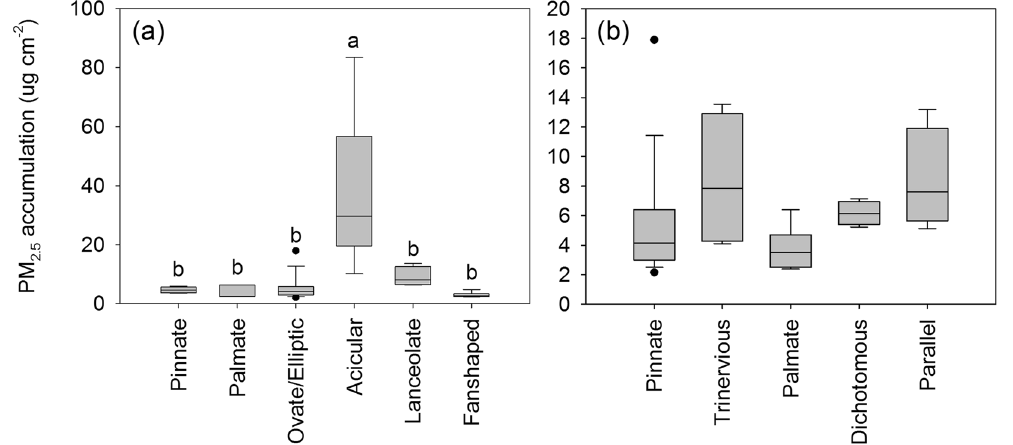
Figure 2. Differences in foliar PM 2.5 accumulation between different leaf shapes ( a ) and venation patterns ( b ) pooled from all species measured. Bars are means ± SE. Different letters above the error bars indicated significant differences between leaf shapes (Bonferroni test, α =